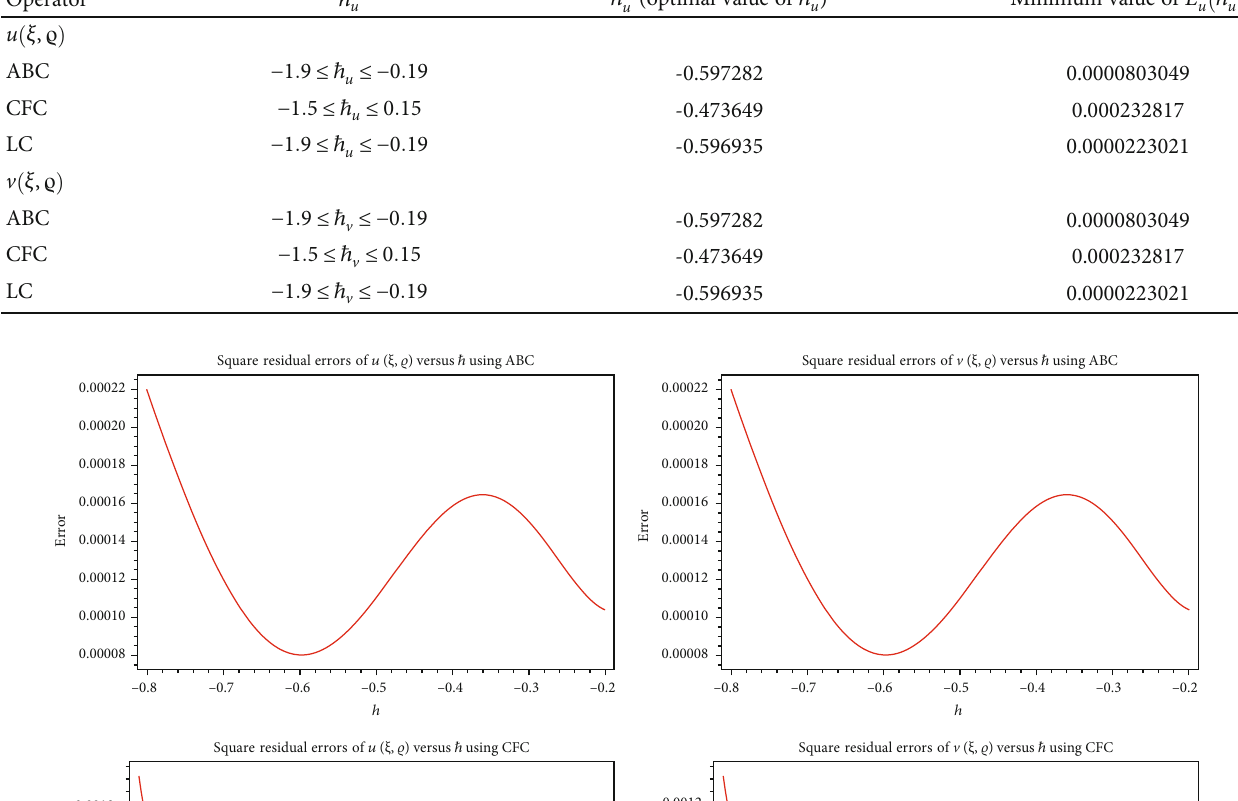
Table 5: Regions of convergence, optimal values of ℏ